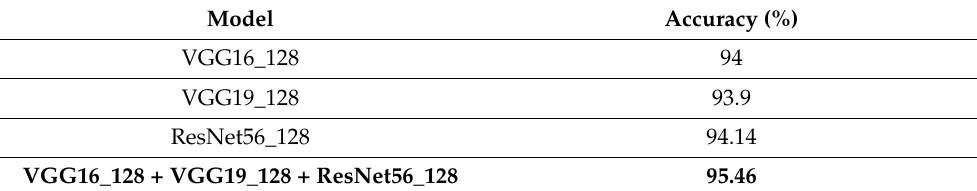
Table 5. Comparison with the baseline